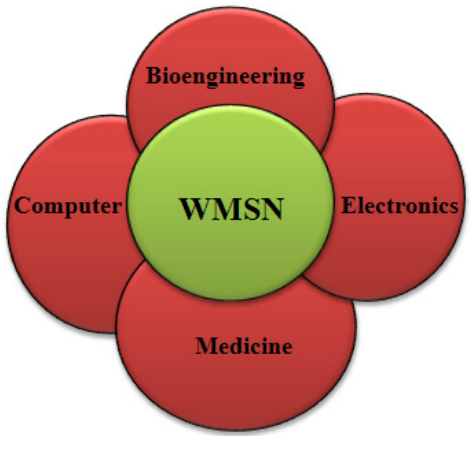
Figure 1. Interdisciplinary research of WMSN.